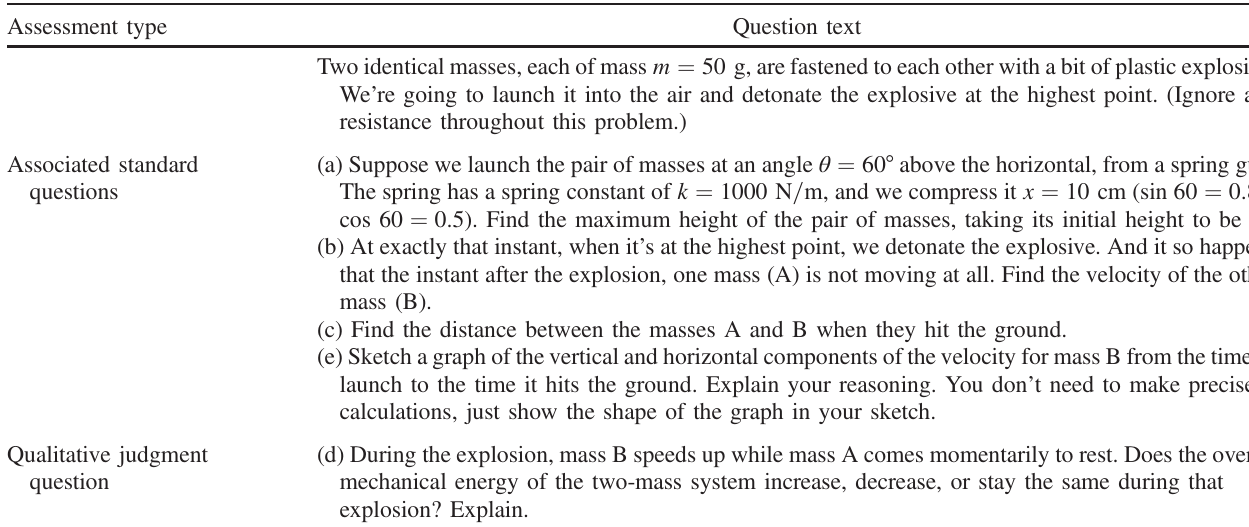
TABLE II. The qualitative judgment question and associated standard